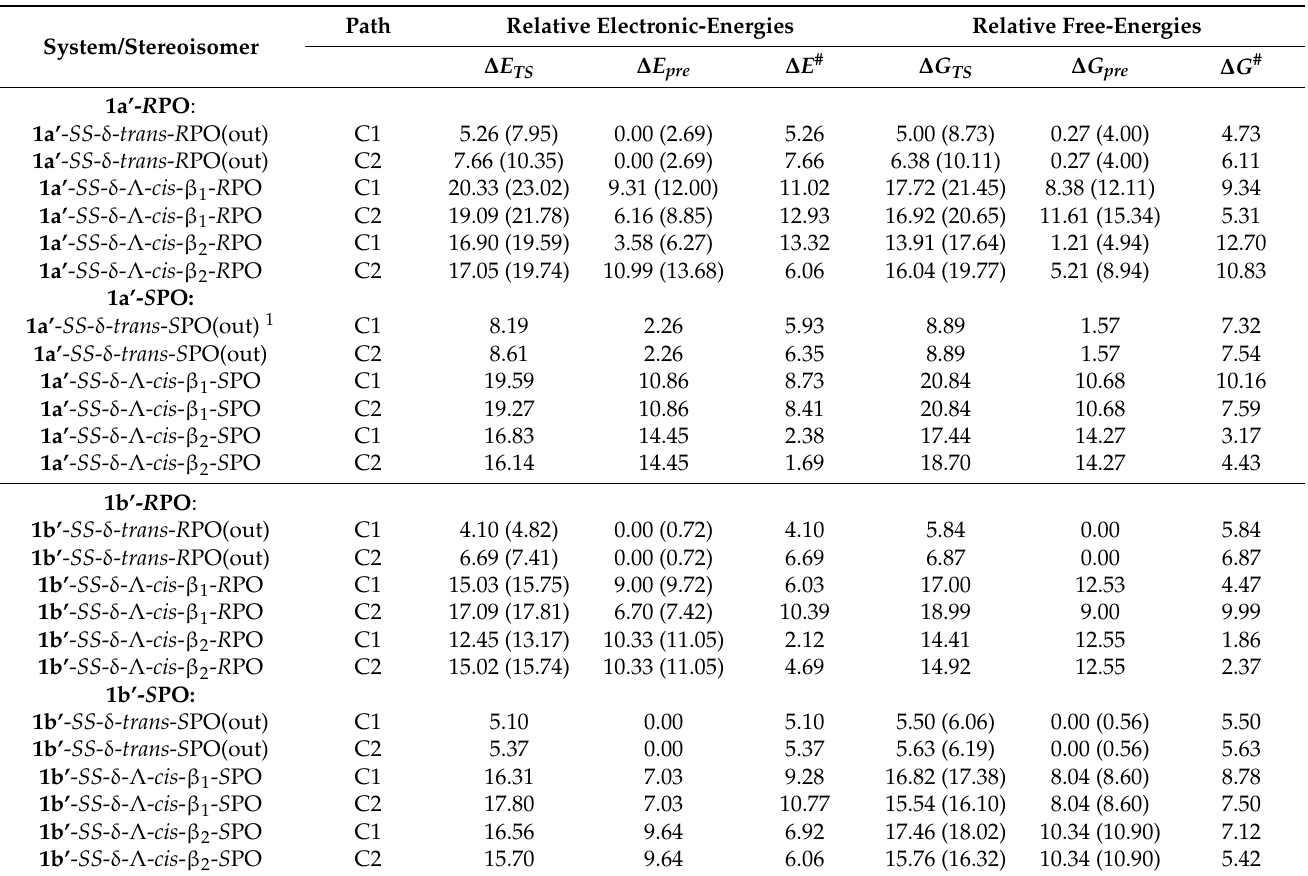
Table 2. Summary of the most important epoxide-opening reaction pathways for the stereoisomers of 1a’ and 1b’ : the relative electronic energies and free energies for TS and prereactive complexes, and the corresponding activation barriers (in kcal/mol). The relative electronic energies/free energies for TS ( ∆ E TS and ∆ G TS ) and prereactive complexes ( ∆ E pre and ∆ G pre ) are calculated with respect to the minimum-energy R PO or S PO 1 complex, while the numbers in parentheses correspond to the relative electronic-energy/free-energy values calculated with respect to the “global minimum” epoxide complex. The activation barriers are expressed with respect to the corresponding prereactive complexes. Path Relative Electronic-Energies Relative Free-Energies System/Stereoisomer ∆ E ∆ E TS